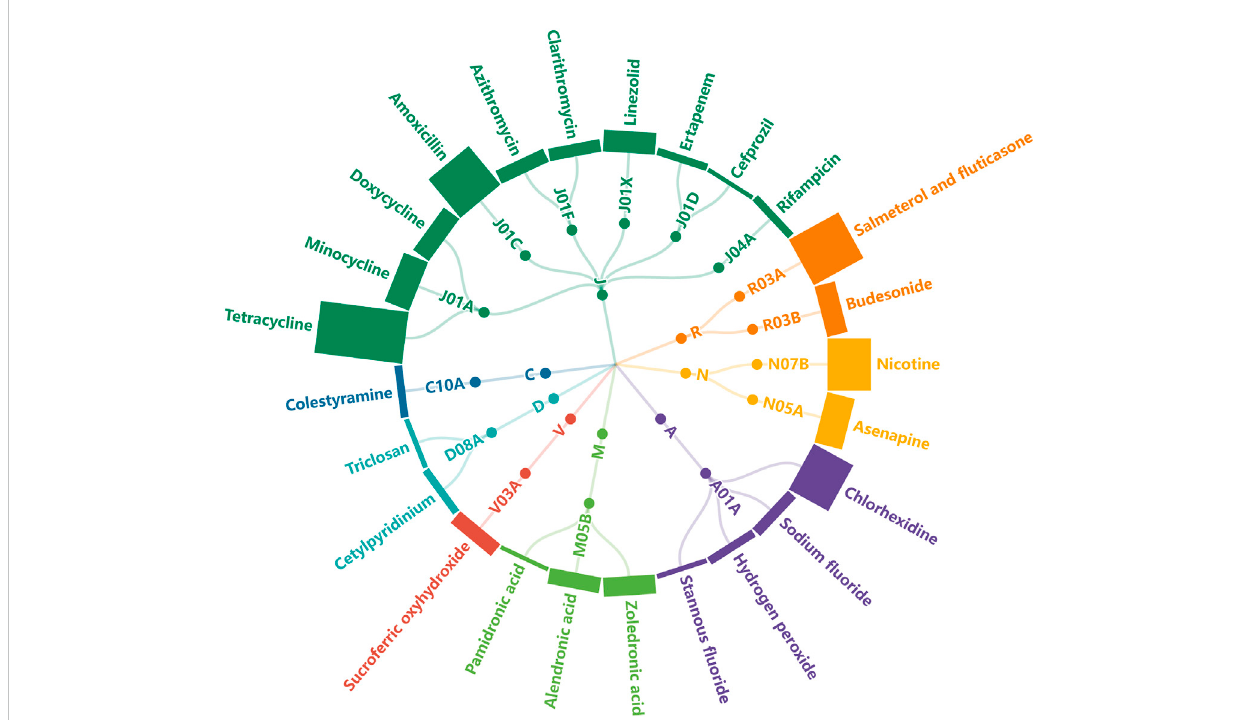
FIGURE 2 Radical tree of drugs grouped by ATC class. The height of each column represents the number of submitted AE reports (J: anti-infectives for systemic use, R: respiratory system, N: nervous system, A: alimentary tract and metabolism, M: musculo-skeletal system, V: various, D: dermatologicals, C: cardiovascular